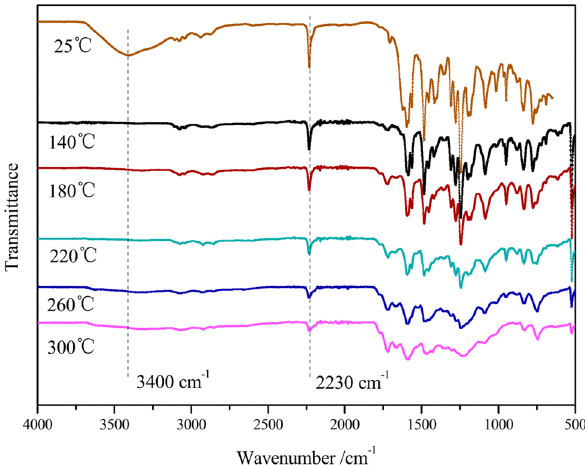
Figure 6: FT - IR spectra of PNR at di ff erent